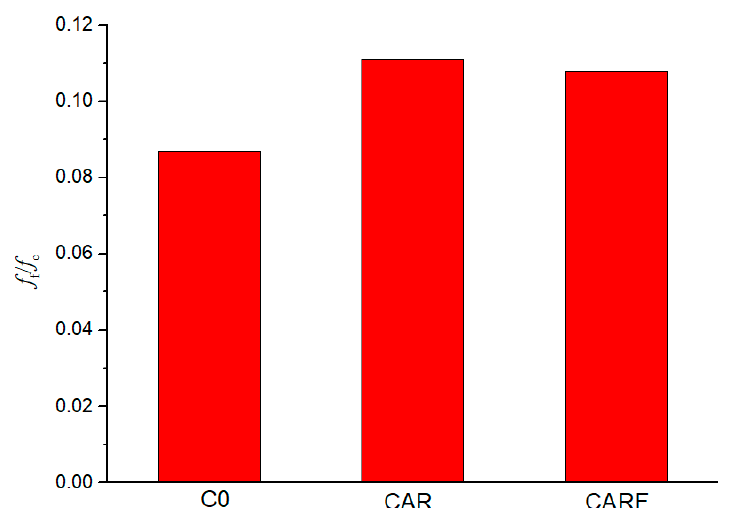
Figure 6. The ratios of flexural strength to compressive strength ( f f / f c ) of specimens incorporating toughening materials.